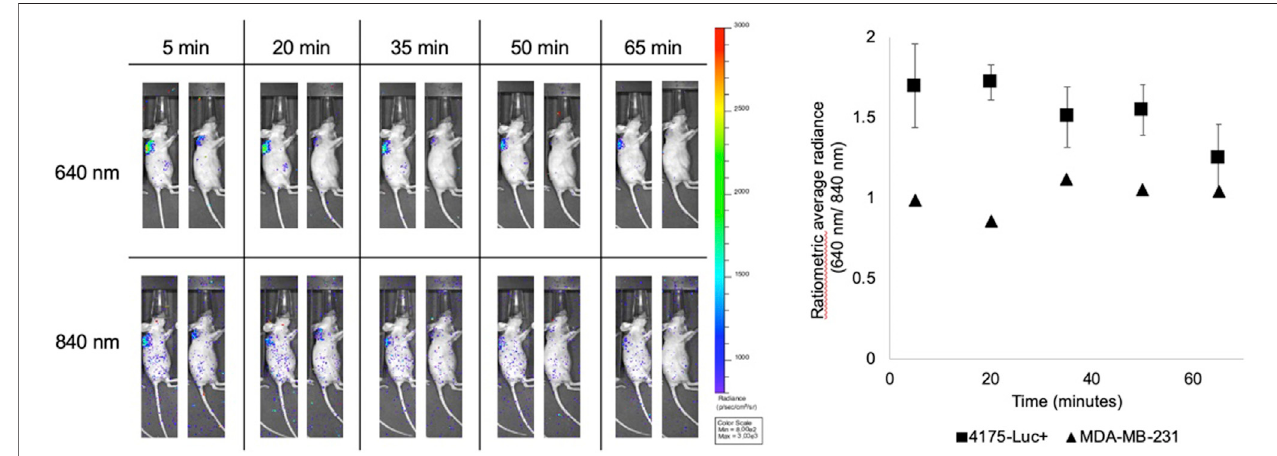
FIGURE5| Invivo activation of 18 F-MFRAin 4175-Luc+ and MDA-MB-231 tumors.0.7 MBq in 20 µlof 18 F-MFRAwere intratumorally injected into tumor-bearing mice to compare the activation rate of the probe in two tumors types: 4175-Luc+ (left, n (cid:2) 4) and MDA-MB-231 (right, n (cid:2) 1). Cerenkov images show the emission detected in the 640 nm fi lter (Top), where we expect to see CRET, and in the 840 nm fi lter (Bottom), which were used for normalization to account for radioactive decay and probe concentration. The graph on the right shows the quanti fi cation of the probe as a function of time. As observed previously, 18 F-MFRA seems to be immediately reduced in the 4175-Luc + tumors as evidenced by the CRET detected in the 640 nm fi lter at the earliest time point (t (cid:2) 5 min). The signal decreases with time, which suggests the washout of the probe. The MDA-MB-231 tumor shows a slower rate of reduction, almost reaching the same signal by the endpoint of the experiment. In this tumor, we expect two mechanisms are acting in concert: the activation of 18 F-MFRA and the washout of the probe from the tumor.